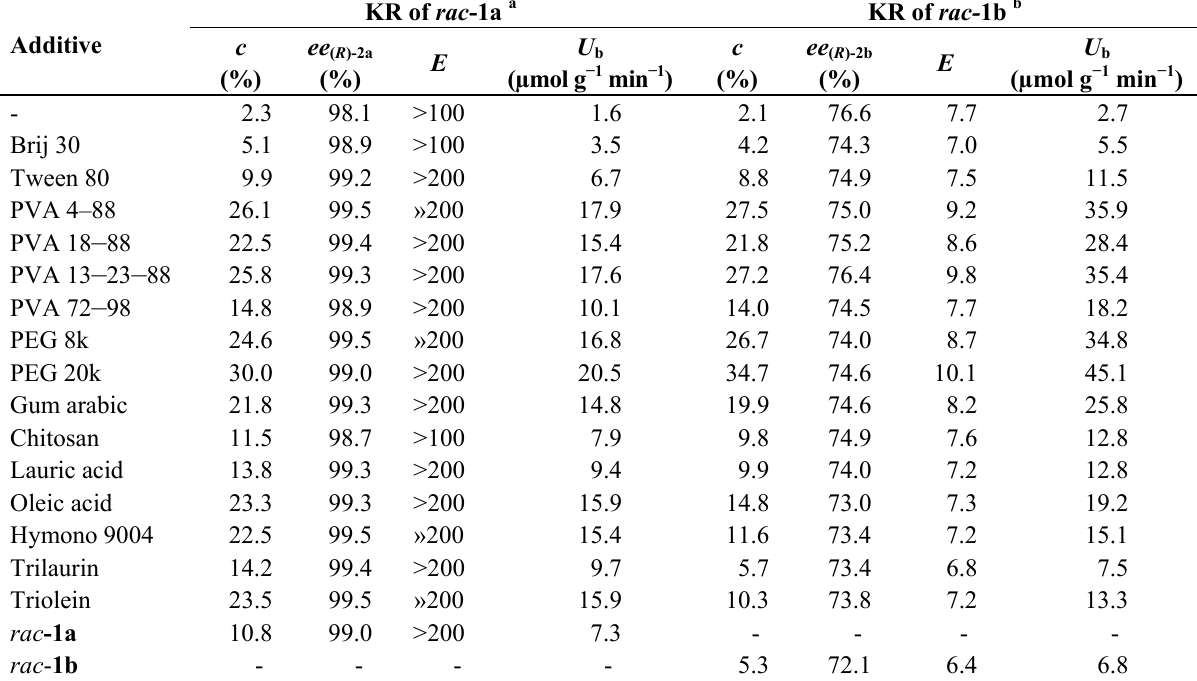
Table 1. Biocatalytic properties of Bc L adsorbed onto mixed function-grafted silica supports in the kinetic resolution of rac- 1a and rac - 1b in batch mode.